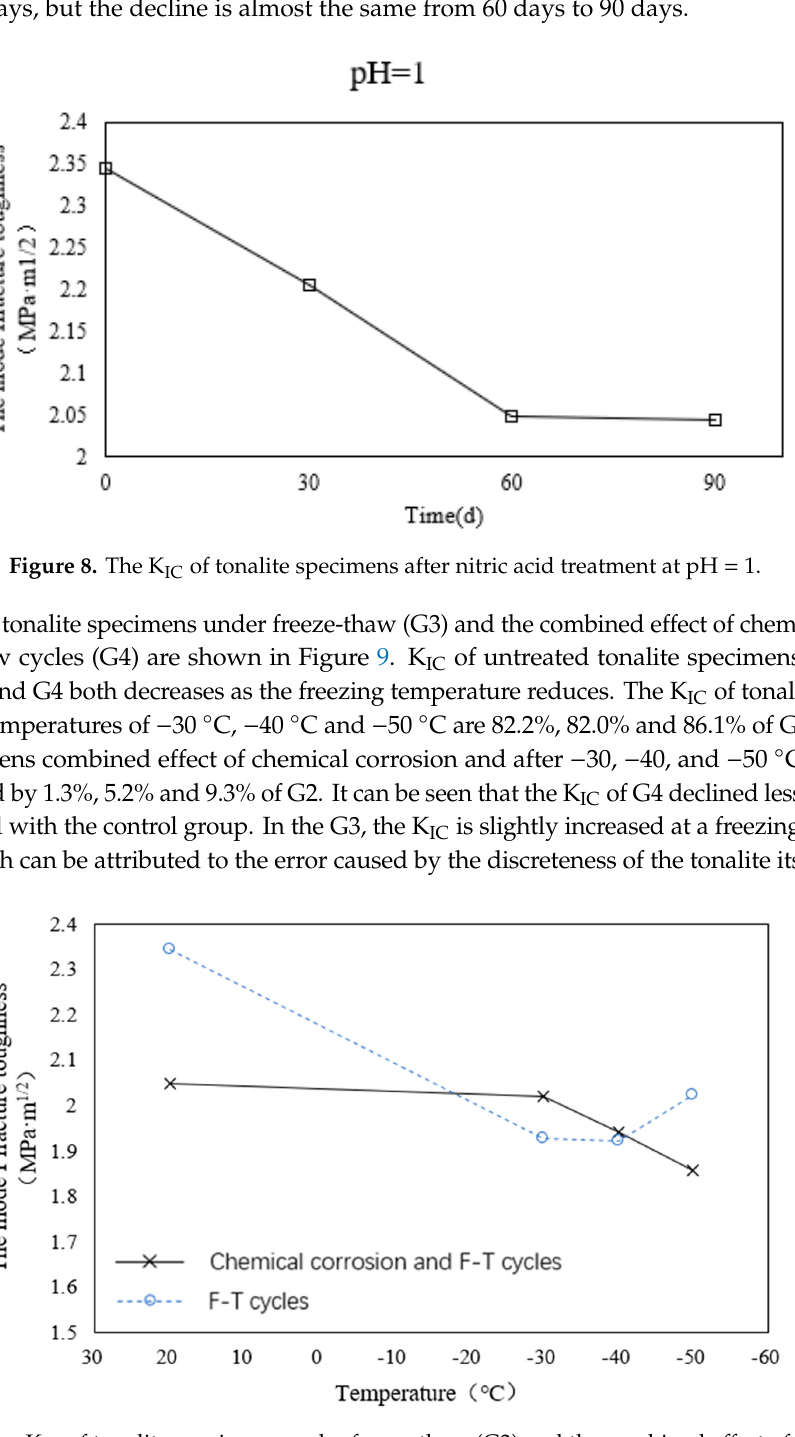
Figure 7. Compressive stress-strain curves for tonalite of subjected to combined effect weathering (G4).